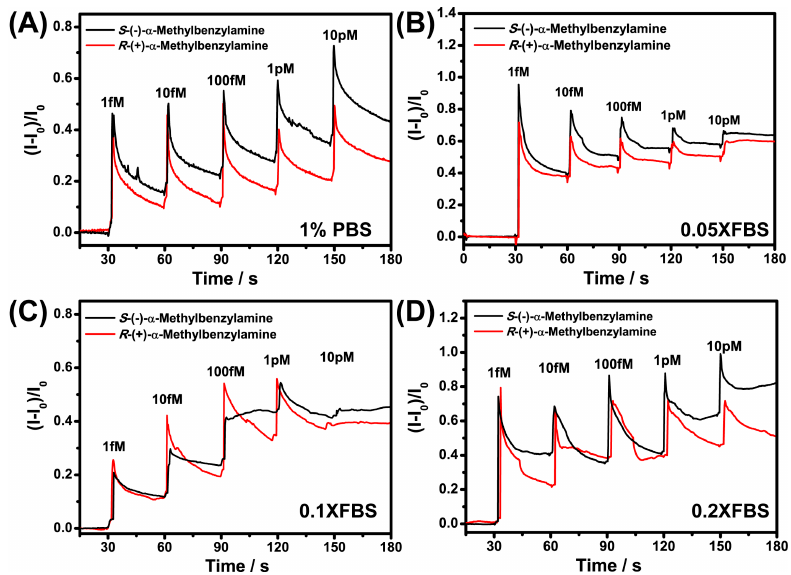
Figure 8. Comparison of chiral recognition ability of the Nafion–GO@BSA–EG-MOSFET platform for α -Met enantiomers in 1% PBS ( A ) and 20-fold ( B ), 10-fold ( C ) and 5-fold ( D ) diluted FBS, respectively.